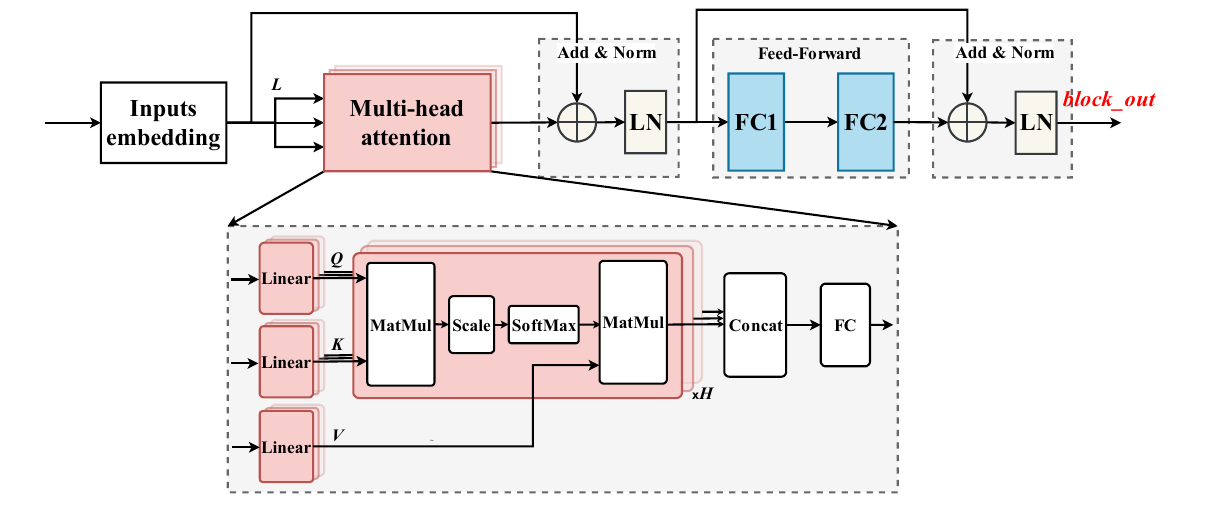
Figure 1. Model architecture of the transformer encoder.